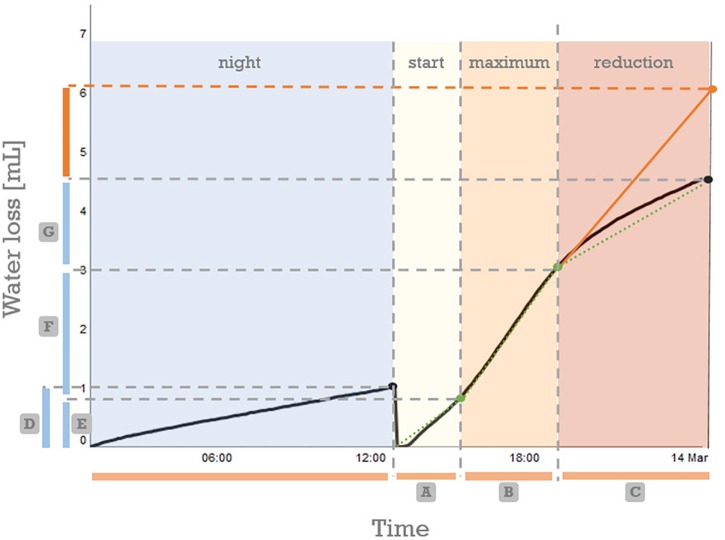
Segmented regression on the cumulative (daily) transpiration pattern allows to separate the transpiration into four distinct parts. For calculation purposes the data is reset to zero at every light switch (12:00 and 00:00). Based on the breakpoints (indicated green dots) derived by segmented regression analysis different base variables are directly derived from the graph: (A) duration of the start segment, (B) duration of the segment with maximal transpiration, (C) duration of the segment with pre-night reduced transpiration, (D) the volume of water lost during the night, (E) the water loss during the start segment, (F) the volume of water lost in the maximum segment, (G) the water lost in the reduced transpiration phase. For all 23 calculated variables using these based variables, see Table 2.